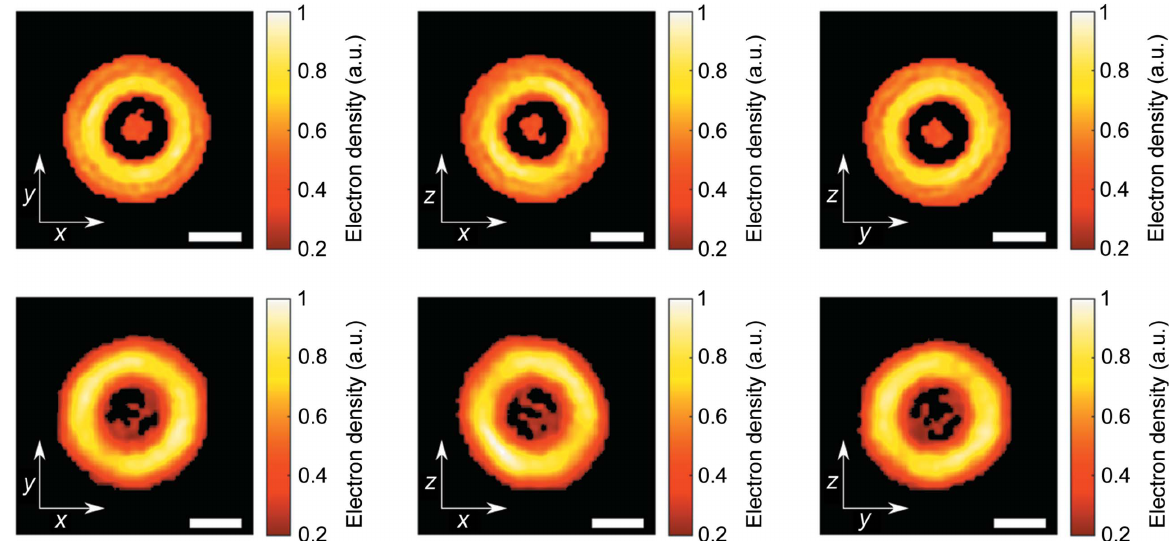
Figure 7 Central slices of the TBEV reconstructions. Upper row: 5o6a; lower row: 5o6v. Electron density values are normalized to the maximum, values less than 0.2 are shown in black. The scale bar is 20 nm.